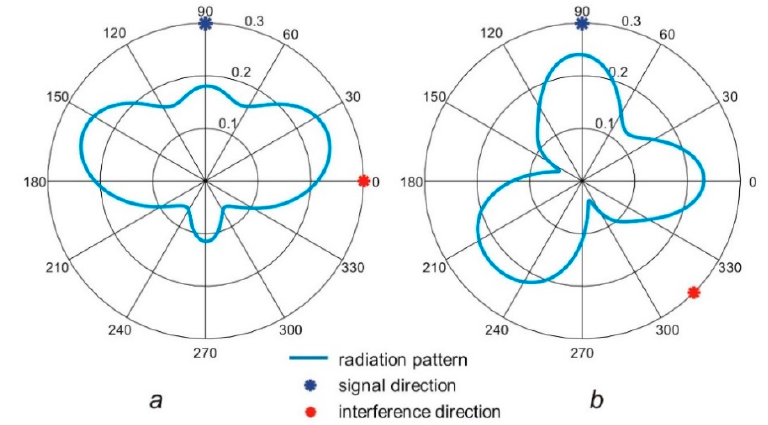
Figure 17. The radiation patterns of the antenna array for the worst combination of signal and interference angles: ( a ) before optimization, ( b ) after optimization.